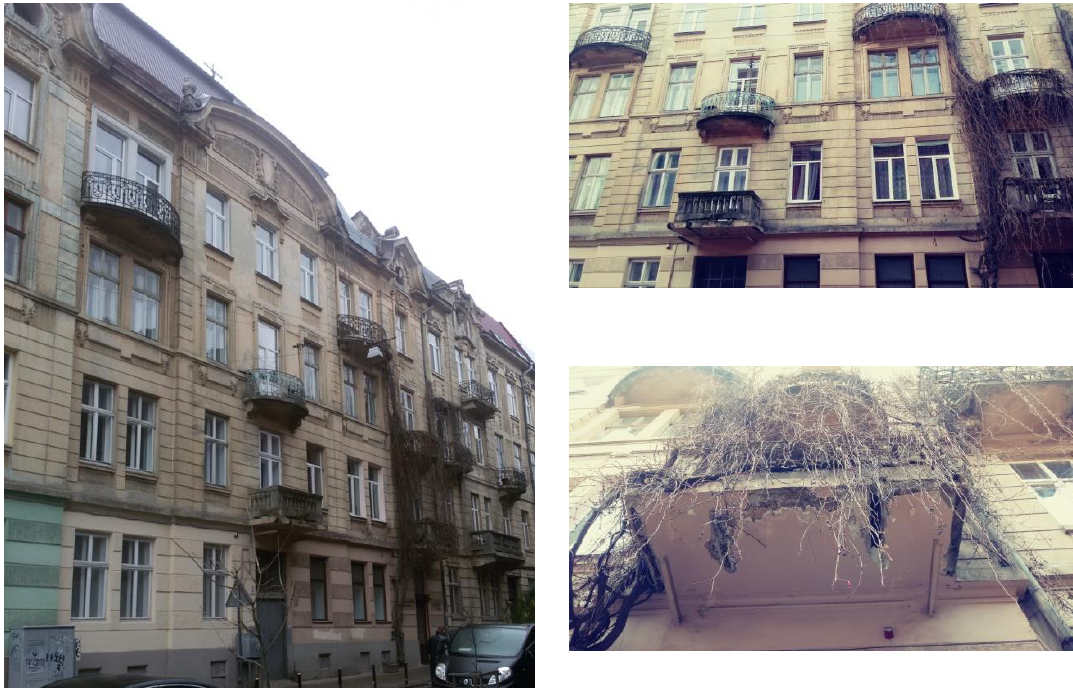
Figure 2. Frontal facade of the building and view of the building’s balcony slabs.